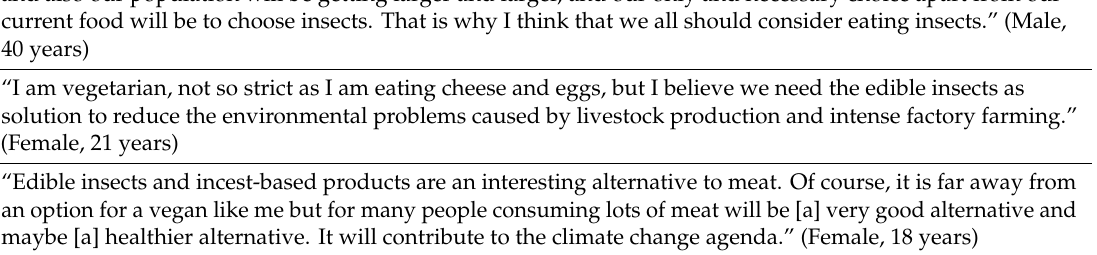
Table 10. Vegetarians about eating insects, 2019